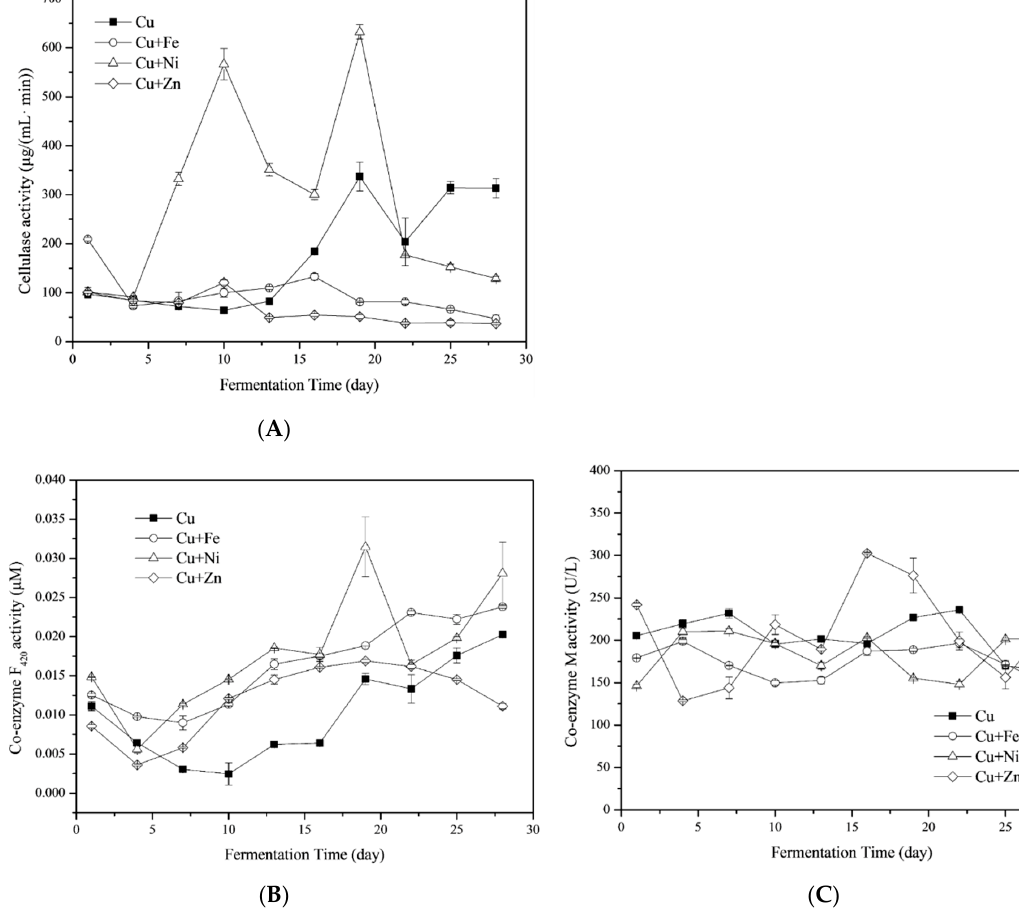
Figure 6. Responses of cellulase ( A ), coenzyme F 420 ( B ) and coenzyme M ( C ) to Fe, Ni and Zn combined with Cu.